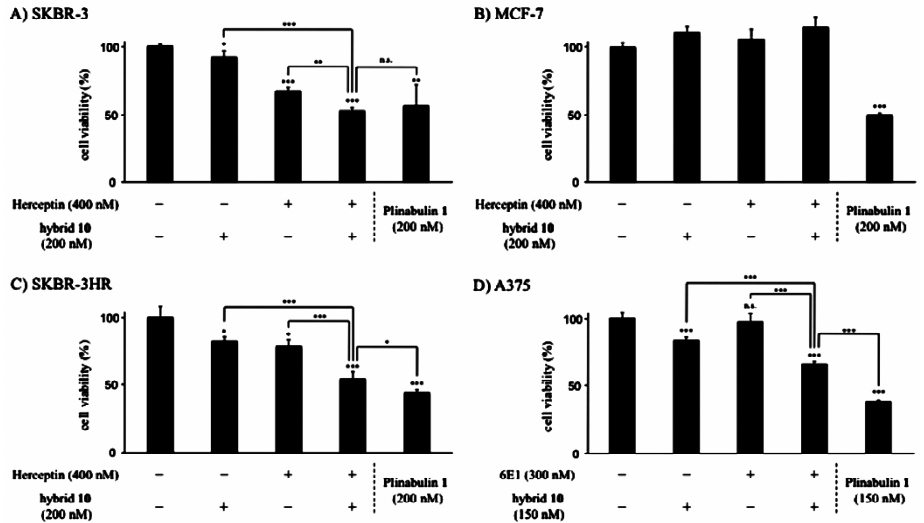
Figure 10. Cytotoxicity of NC-ADC, complex of hybrid 10 and Herceptin, against ( A ) SKBR-3 cells; ( B ) MCF-7 cells; and ( C ) SKBR-3HR cells; ( D ) cytotoxicity of noncovalent ADC, complex of hybrid 10 and 6E1 against A375 cell. n.s.: not significant, * p < 0.05, ** p < 0.01, *** p < 0.005. Data ( n = 3) are shown as means ± SD. Adapted from [75] with permission from © 2016 American Chemical Society.